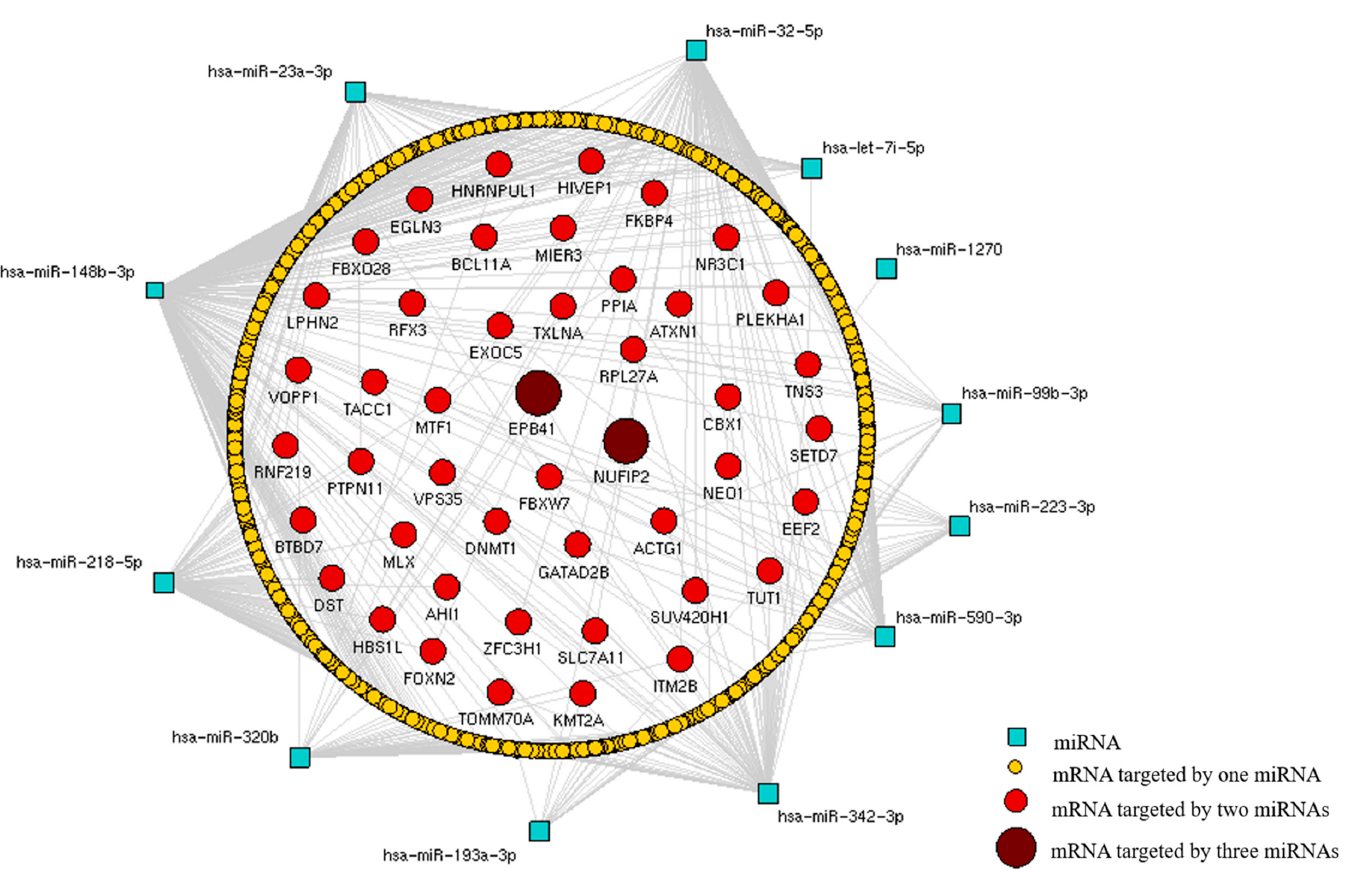
Figure 6. MiRNA-mRNA interaction networks to identify target genes regulated in cells infected with yeasts from distinct H. capsulatum strains. MiRNA-mRNA interaction networks identify target genes regulated in cells infected with different strains of H. capsulatum . The interaction network was constructed with the Navigator software v2.2 from triplicate analyses. Differentially expressed miRNAs were analyzed using the miRWalk software. Target genes regulated by differentially expressed miRNAs were analyzed in the following pair comparisons: THP-1 Mø-like cells infected with the EH-315 strain grown in planktonic form vs. uninfected THP-1 Mø-like cells, THP-1 Mø-like cells infected with the 60I strain grown in planktonic form vs. uninfected THP-1 Mø-like cells, and THP-1 Mø-like cells infected with the EH-315 strain grown in biofilm form vs. uninfected THP-1 cells. MiRNAs are represented by squares. Most genes indicated by their mRNAs (yellow circles) are targeted by a single specific miRNA, whereas the remaining genes (red and dark red circles) are simultaneously regulated by two or three distinct